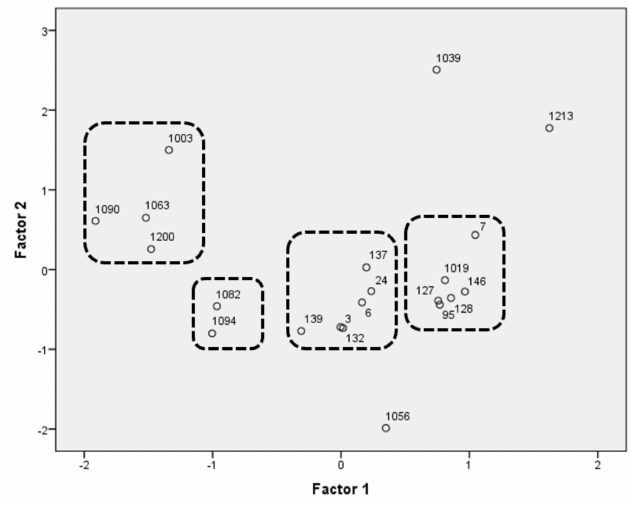
Figure 6. Principal component analysis run on the fitting parameters of the functional characteristics. Case projection (yeast distribution as a function of the variables). Dotted line represents groups of strains with the similar